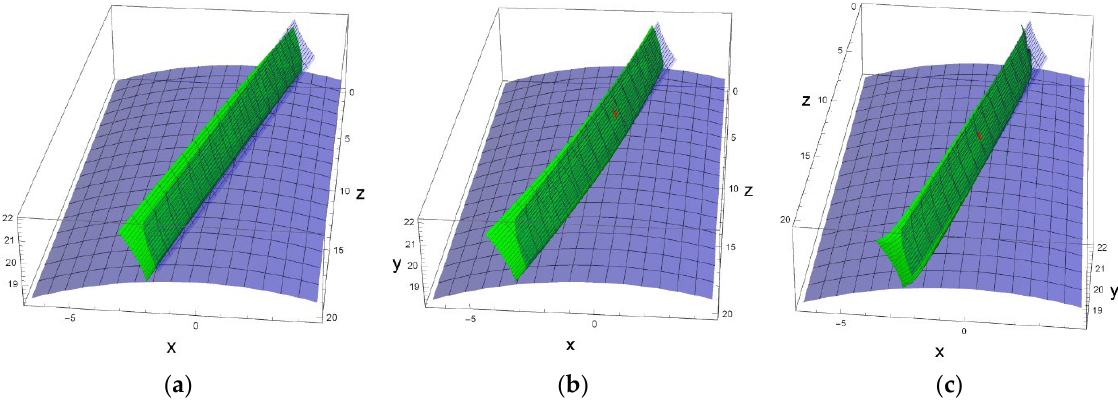
Figure 22. Example of helical gear assembly models in space with: ( a ) unmodified tooth, ( b ) circular crowning, and ( c ) logarithmic crowning.